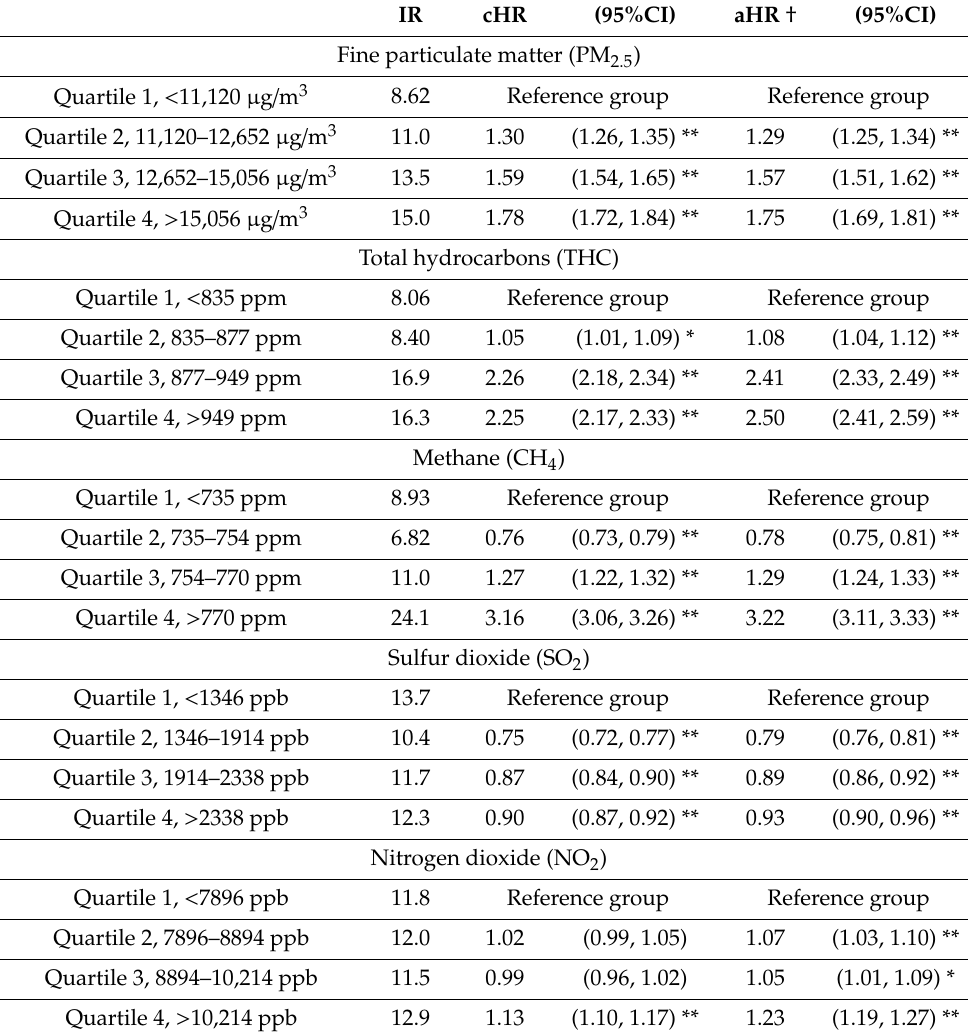
Table 2. The risk of recurrent headaches in children exposed to air pollutants stratified by quartile of annual average concentration in Cox proportional hazard regression.